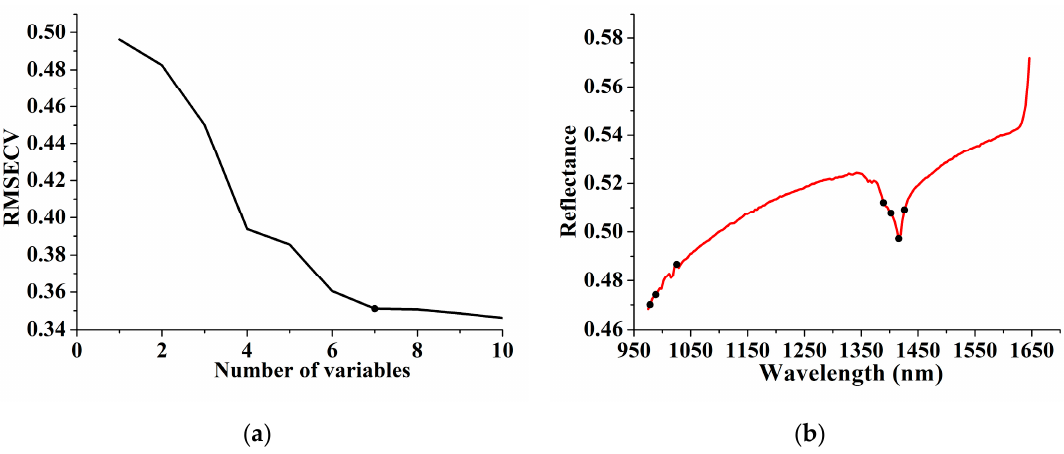
Figure 5. RMSECV curves with the number of variables selected by SPA for soil type classification ( a ). The reference data in SPA was category value. The selected variables (shown as dots) corresponding to raw spectra were presented in ( b ).